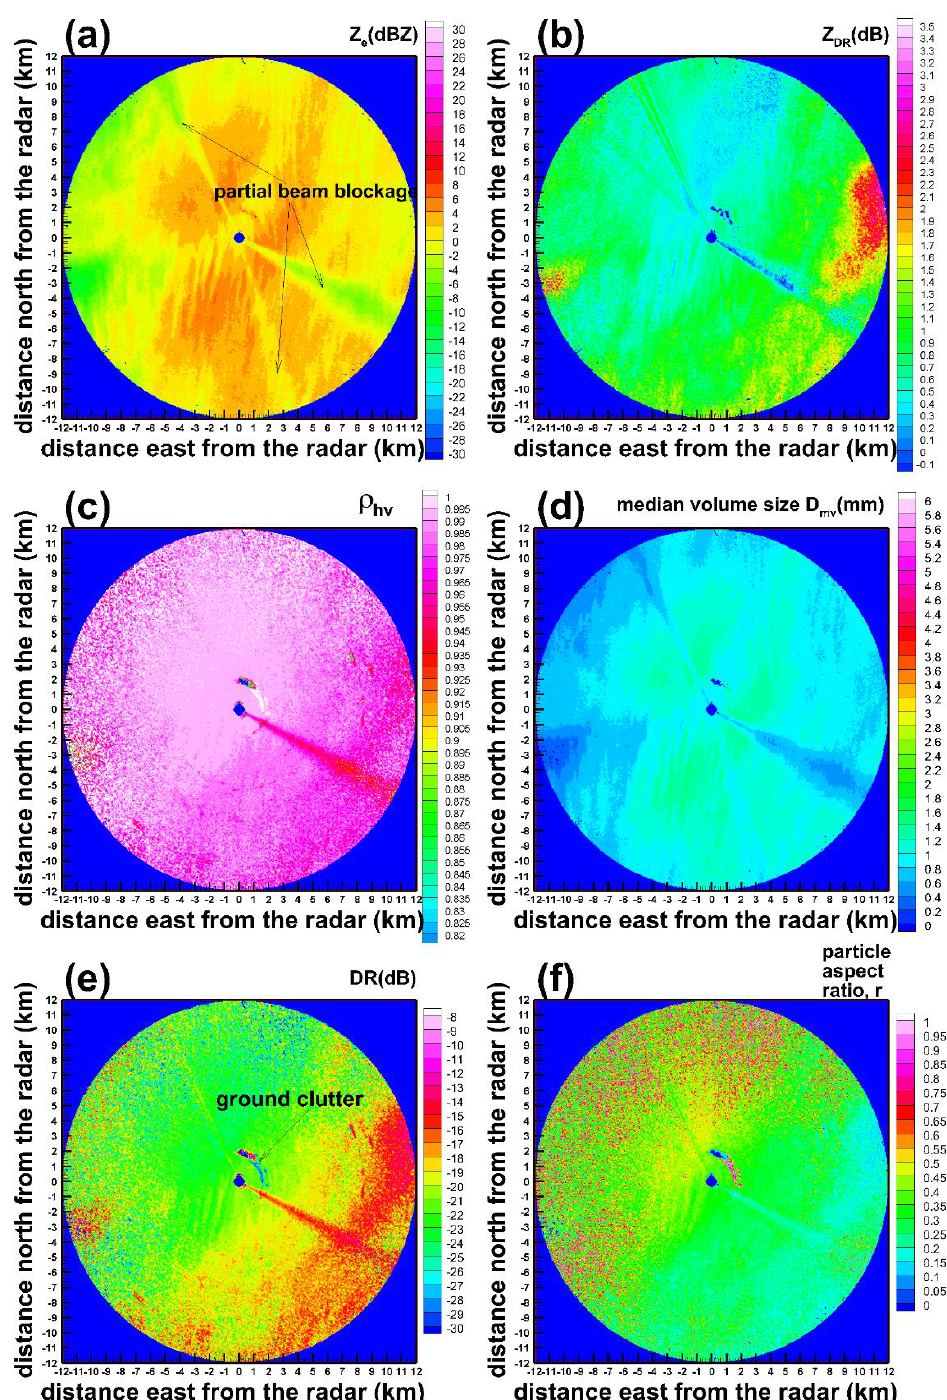
Figure 7. Measurements of horizontal polarization reflectivity ( a ), differential reflectivity ( b ), copolar correlation coefficient ( c ), estimates of depolarization ratio ( e ) and retrievals of particle median volume size ( d ) and aspect ratio ( f ) corresponding to a KDLH radar scan at 5° on 21 October 2016 at 00:52 UTC.